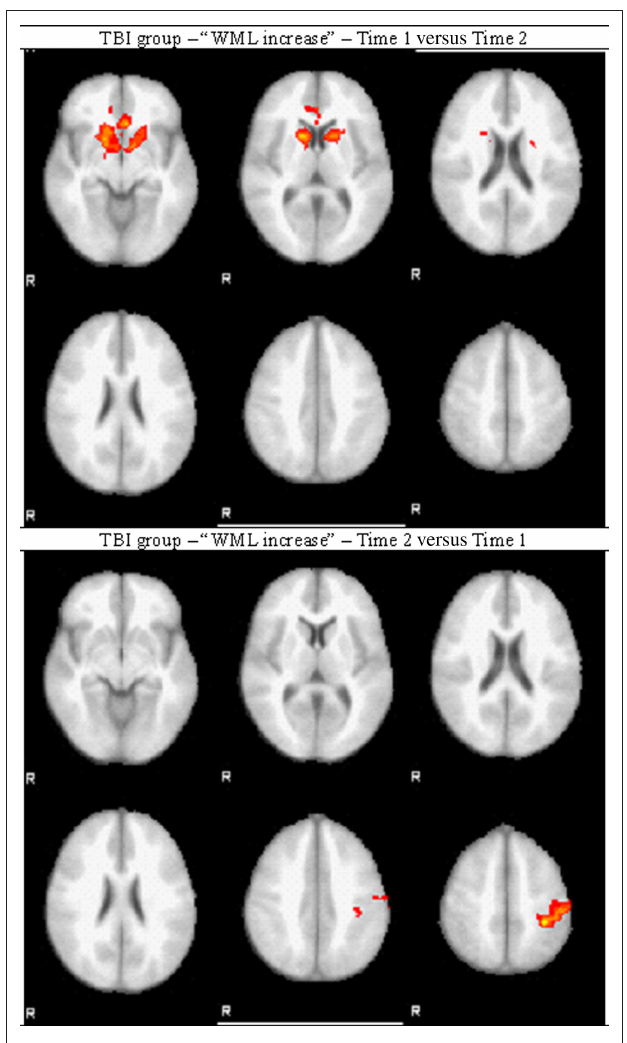
FIguRe 5 | Longitudinal contrasts for TBI